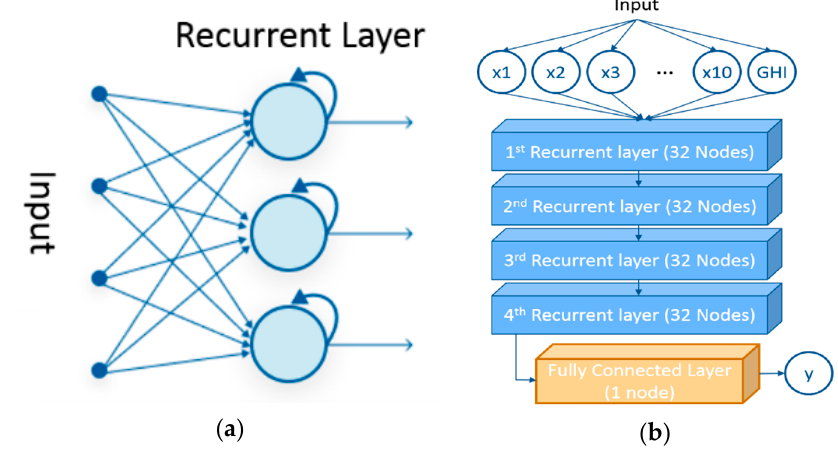
Figure 7. RNN model: ( a ) simple RNN; ( b ) our RNN model.